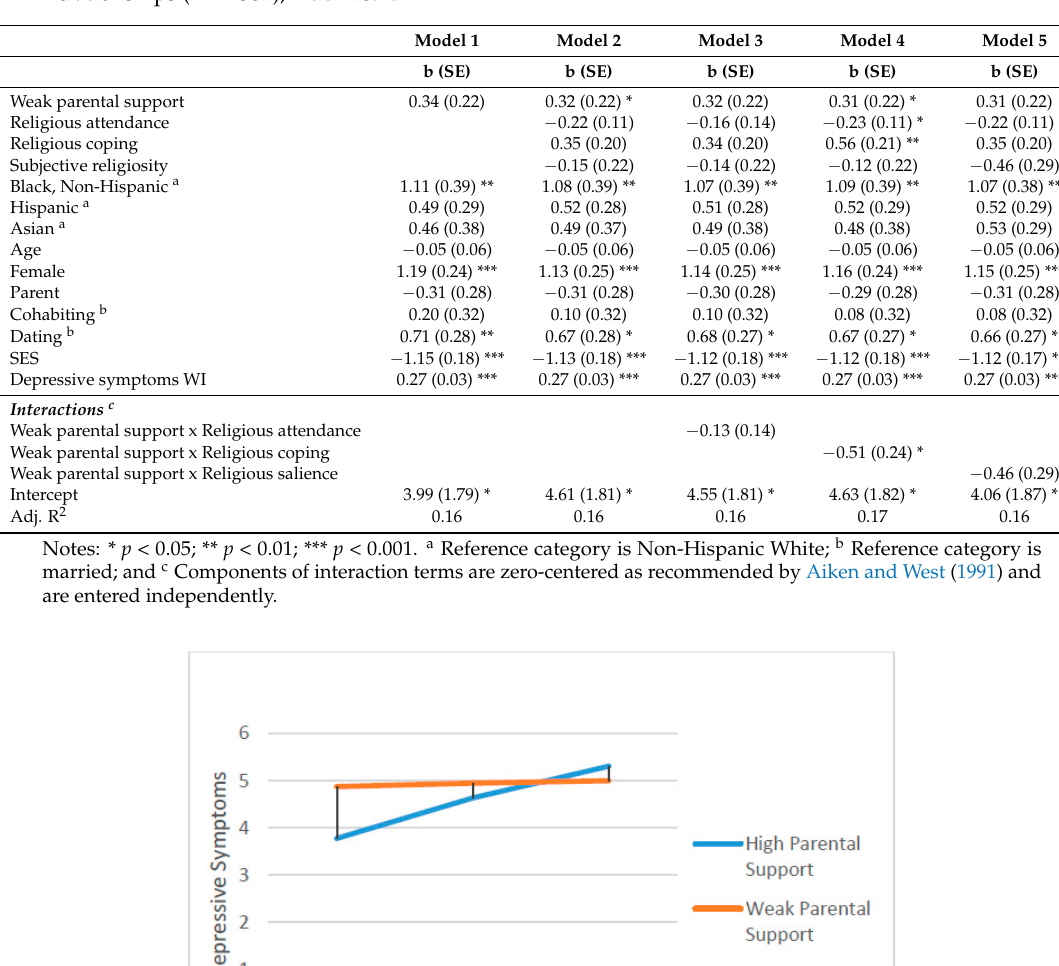
Table 3. Estimated for Weighted Linear Regression Models Predicting Depressive Symptoms, Interracial Relationships (n = 2382), Add Health.